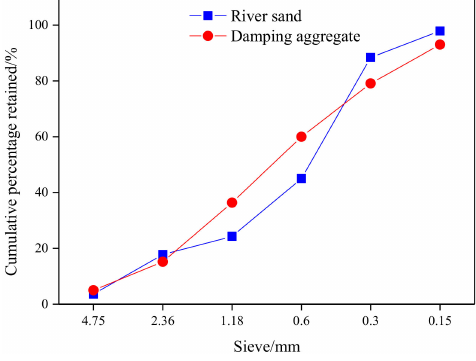
Figure 1. Particle gradation of aggregate. Table 2. Properties of the lightweight porous aggregate.